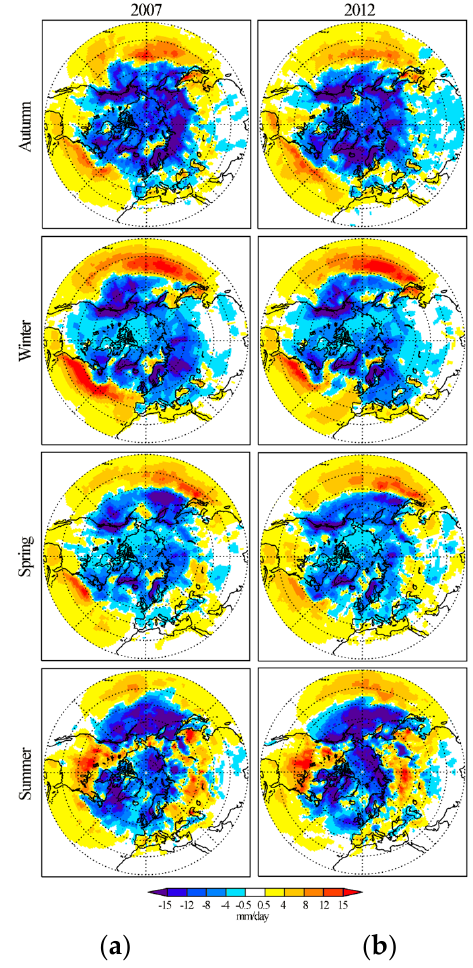
Figure 4. Climatological seasonal 10-day integrated (E–P) values observed for the period 2006/2007 ( a ) and for the period 2011/2012 ( b ), for all the particles bound for the Arctic domain, determined from backward tracking. Red colours represent moisture sources and blue colours represent moisture sinks.